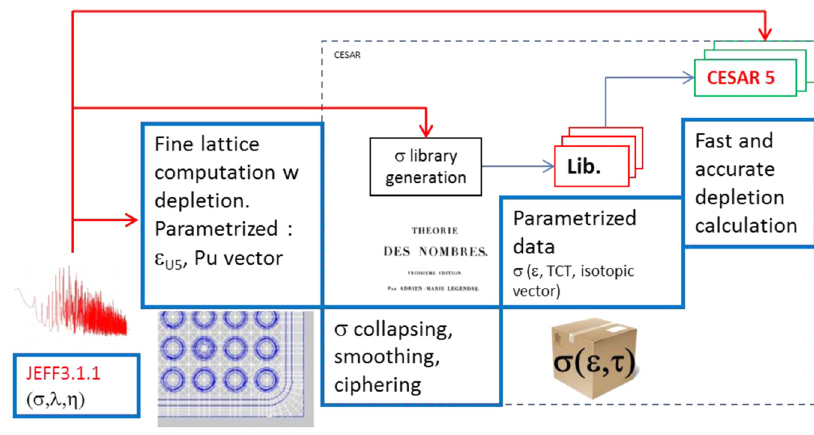
Fig. 1. Cross section generation process. Table 1. Reference computation hypotheses for code performance